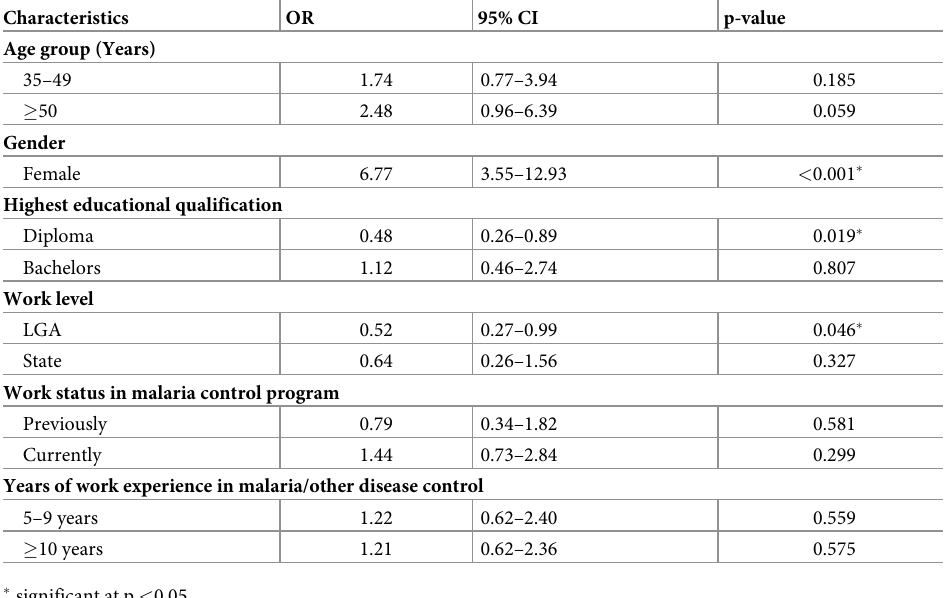
Table 5. Adjusted ordinal logistic regression model for priority rating of selected malaria thematic domains’ topics.